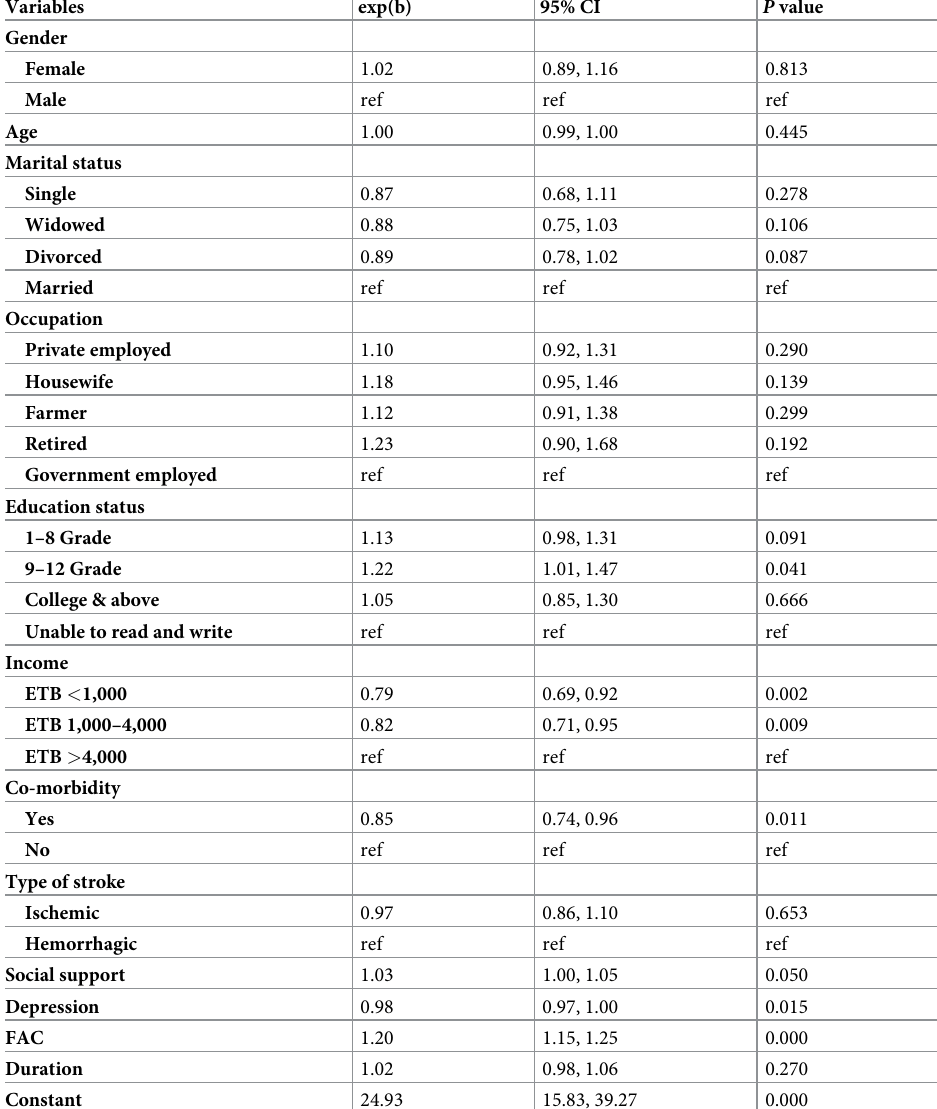
Table 3. Generalized linear model analysis to identify factors associated with PCS among patients with stroke (N = 180).